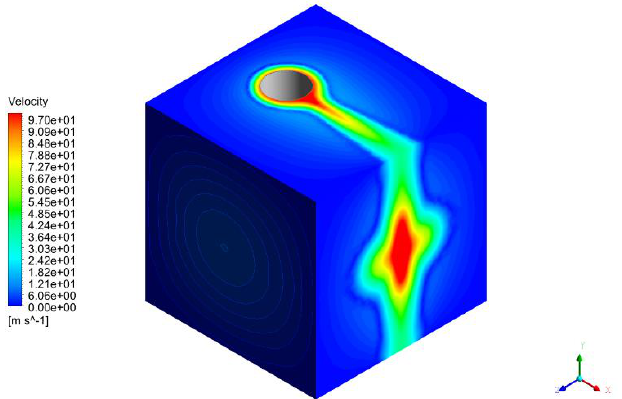
Figure 10. Velocity magnitude contour plot on the SB